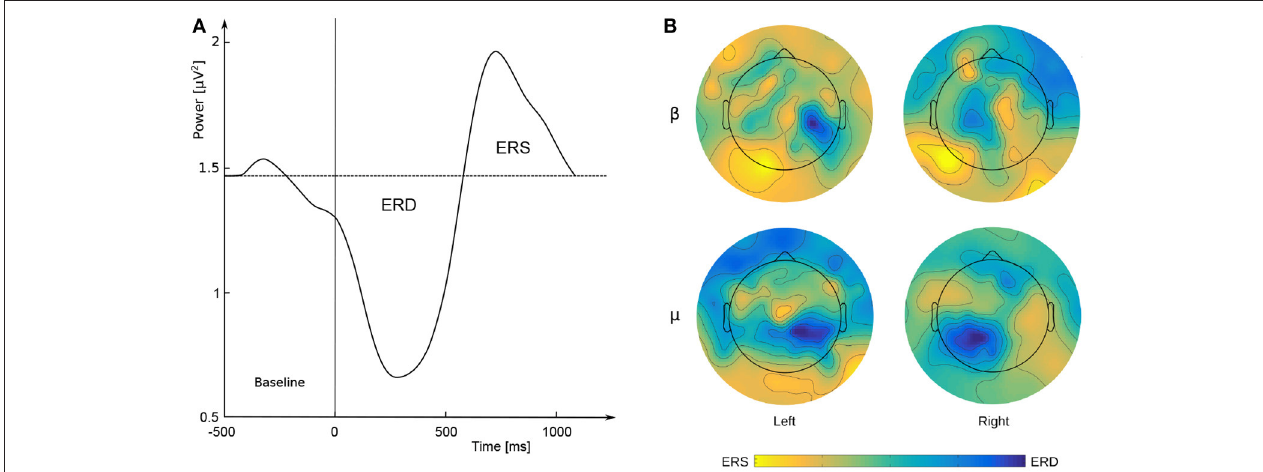
FIGURE 1 | (A) Example of ERD/ERS time courses. The vertical line indicates the beginning of imagery movement. Source: prepared by the authors, based on Lemm et al. (2009), p. 3; (B) maps of signal strength ( µ V 2 ) distribution on the scalp ( µ = 8–12 Hz; β = 18–30 Hz) during imagined movement of the left or right